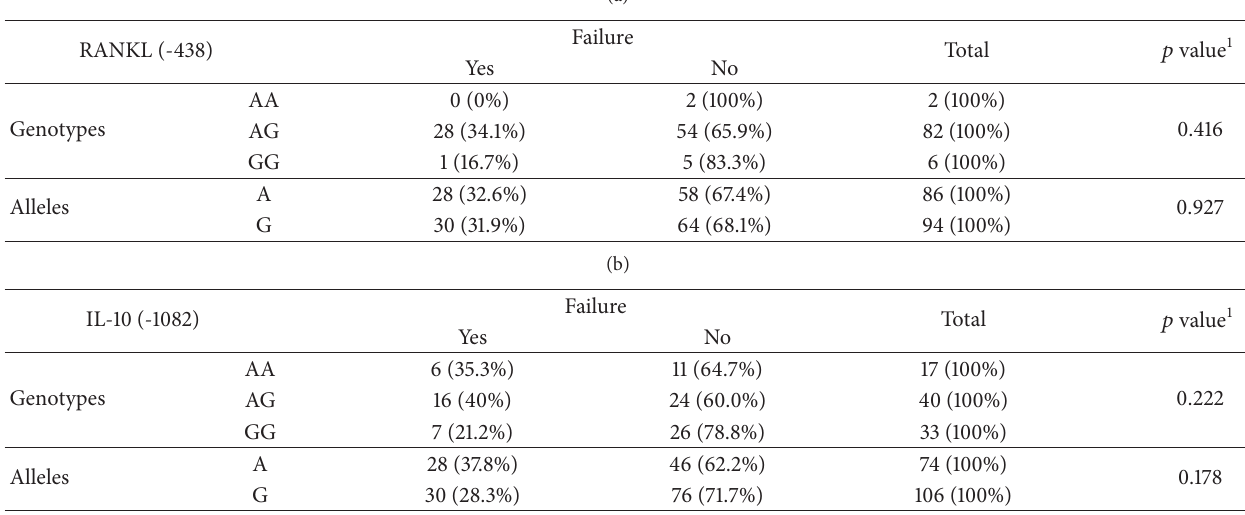
Table 2: Association between failure, genotypes, and alleles for RANKL (-438) and IL-10